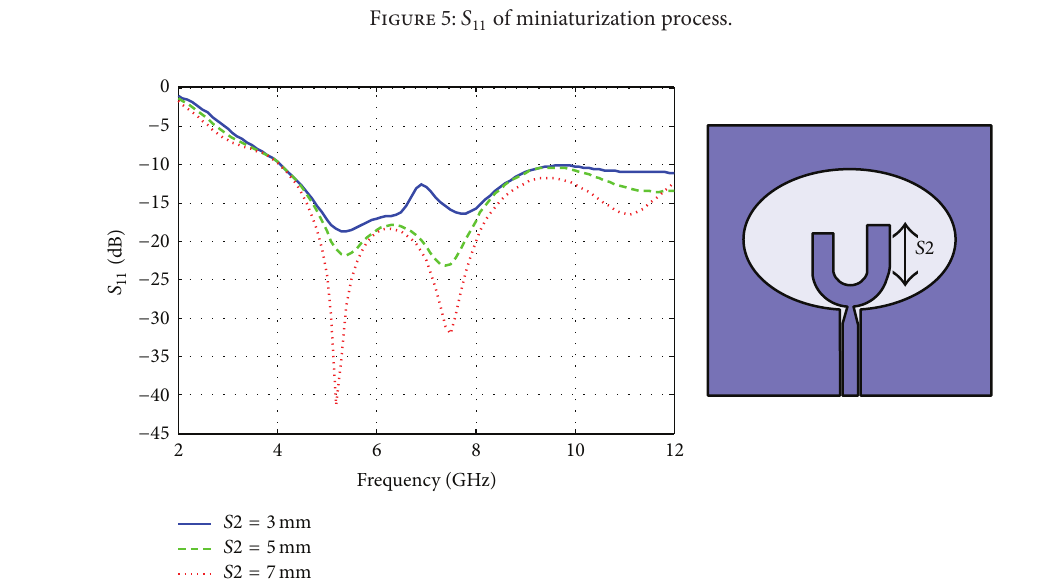
Figure 6: 𝑆 11 with 𝑆 2 variation.